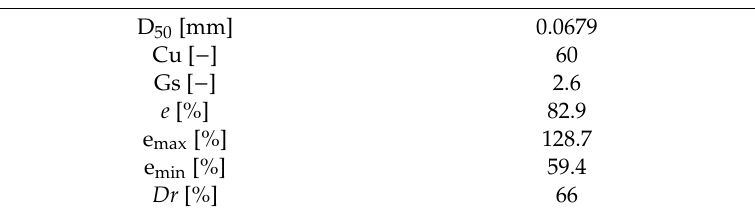
Table 4. Characteristics of the soil at C5. D 50 : mean diameter; C u = D 60 Gs: specific gravity; e : void index; e max : maximum void index; e min : minimum void index; Dr : relative density.